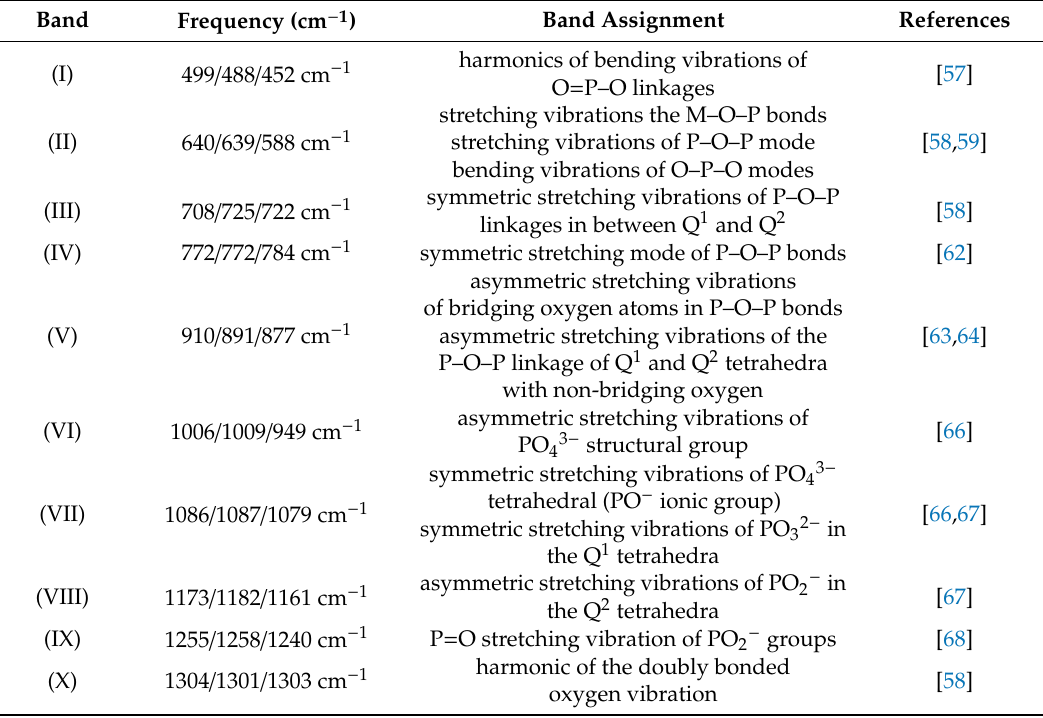
Table 1. Band positions and their